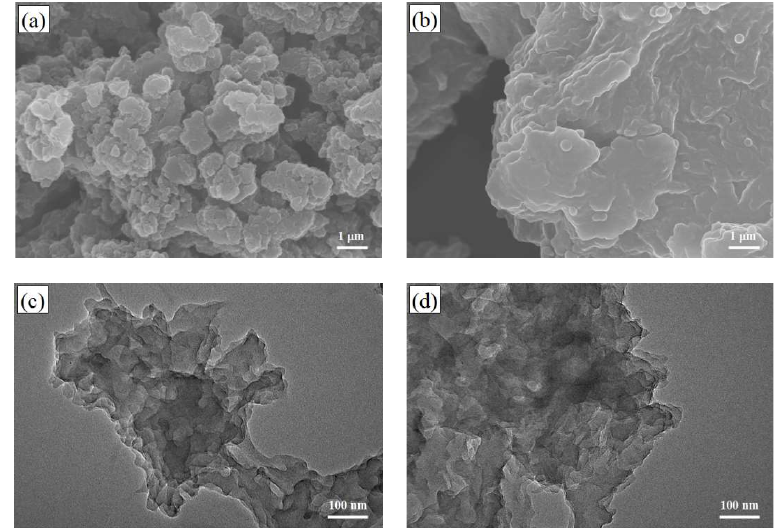
Figure 4. Field emission scanning electron microscopy (FESEM) images of ( a ) POT and ( b ) PMT; Transmission electron microscopy (TEM) images of ( c ) POT and ( d ) PMT.